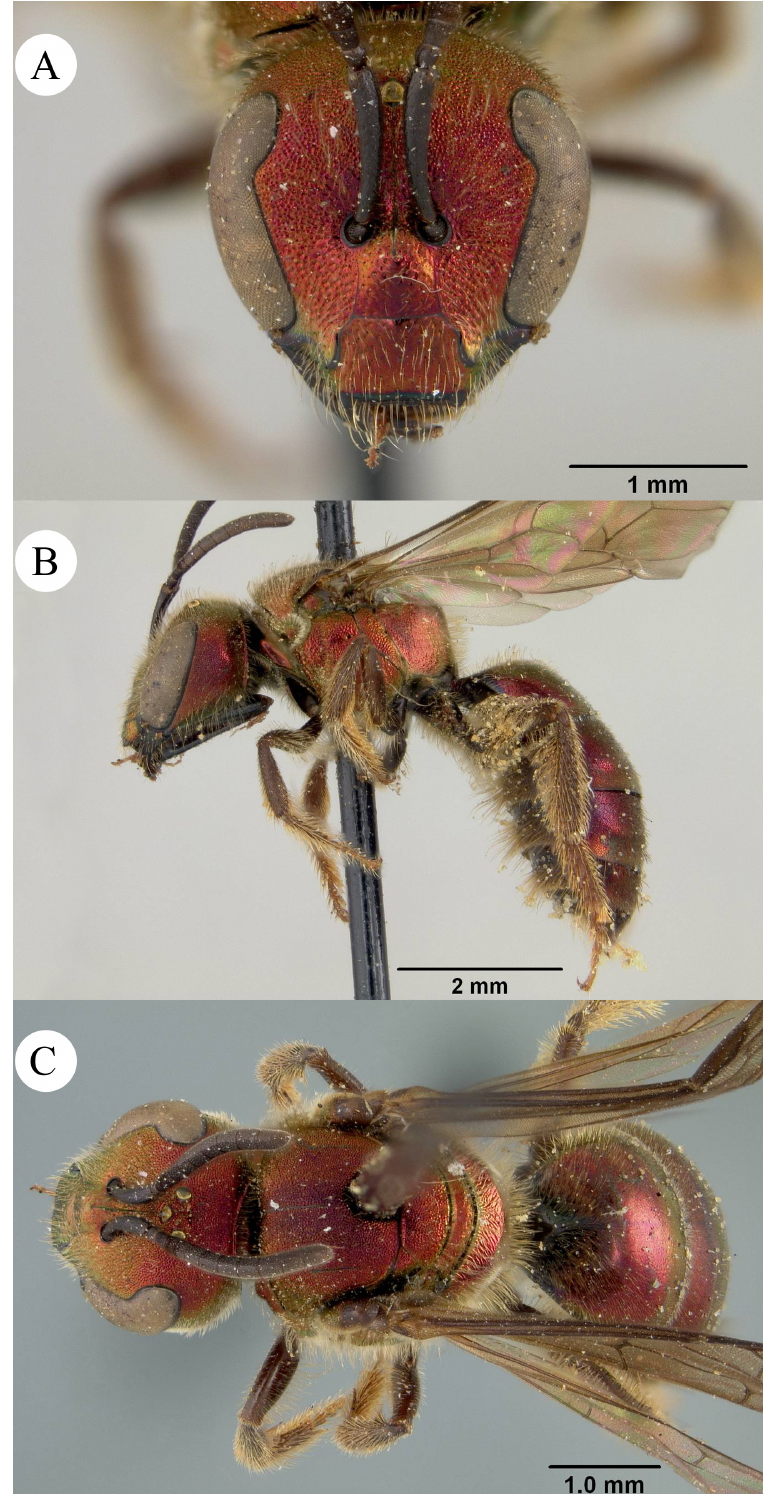
Fig. 22. Augochlora ignifera Crawford, 1914. Holotype, ♀. A . Face. B . Lateral habitus. C . Dorsal habitus. Images of A. ignifera provided with the permission of the National Museum of Natural History, Smithsonian Institution, 10th and Constitution Ave. N.W., Washington, DC 20560-0193 (http://www.